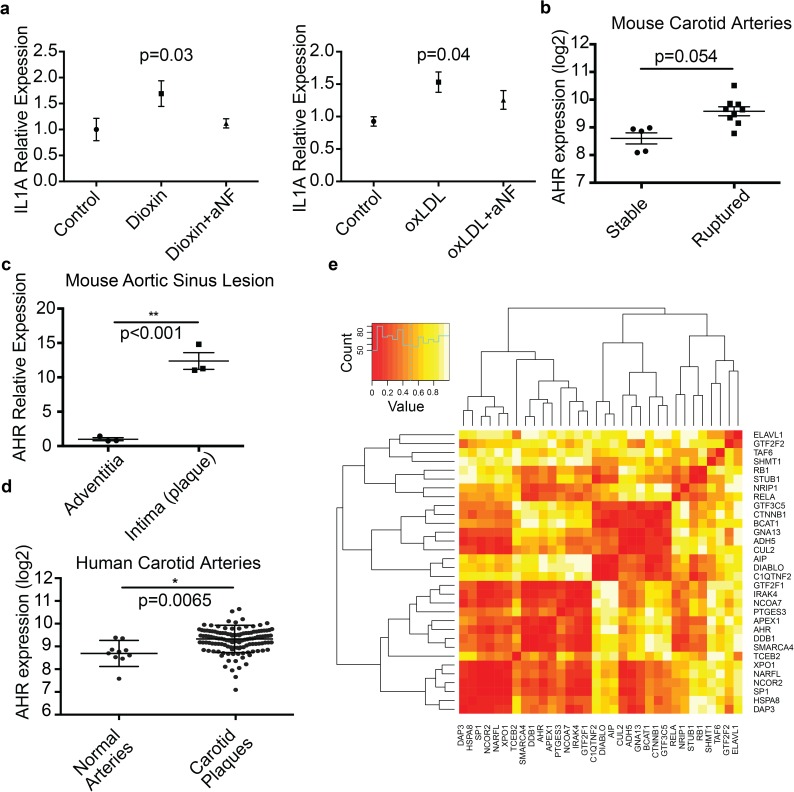
Endogenous regulation of the AHR pathway in SMC, and in vivo expression of AHR in atherosclerotic vascular disease.(a) IL1A mRNA levels are increased by dioxin and ox-LDL, and co-treatment with αNF, an AHR pathway antagonist, reverses these effects. (b) AHR mRNA levels are elevated in ligated carotid arteries with ruptured plaques compared to stable plaques. (c) Laser capture microdissection shows increased AHR mRNA levels to be located in the plaque region of the atherosclerotic aortic root. (d) AHR mRNA levels are elevated in atherosclerotic human carotid arteries compared to normal arteries. (e) In vivo protein expression patterns in human carotid artery plaque tissues. AHR-TCF21 unique interactors from the BIOGRID protein-protein interaction database display clustering patterns in mass-spectrometry and high resolution isoelectric focusing proteomic data from human carotid artery plaques. Proteomic datasets were constructed from patients with asymptomatic (10) and symptomatic (10) carotid stenoses. Mass-spec and high resolution isoelectric focusing yielded 8–9000 recovered proteins. Hierarchical clustering revealed AHR to be located in a cluster of genes that include immune related genes, transcription factors, and cell cycle regulated genes, such as IRAK4, SP1, and XPO1, respectively.